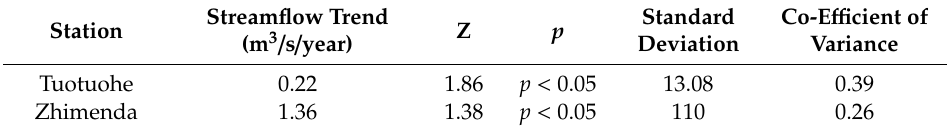
Figure 5. Variation in monthly flows represented by a 25%–75% inter-quantile range (IQR), 99%, and 1% (red triangles) values, mean values, and median values for ( a ) Zhimenda and ( b ) Tuotuohe sub-basins. Table 4. Linear trends in streamflow and modified Mann–Kendall statistics (Z) during 1961–2015.